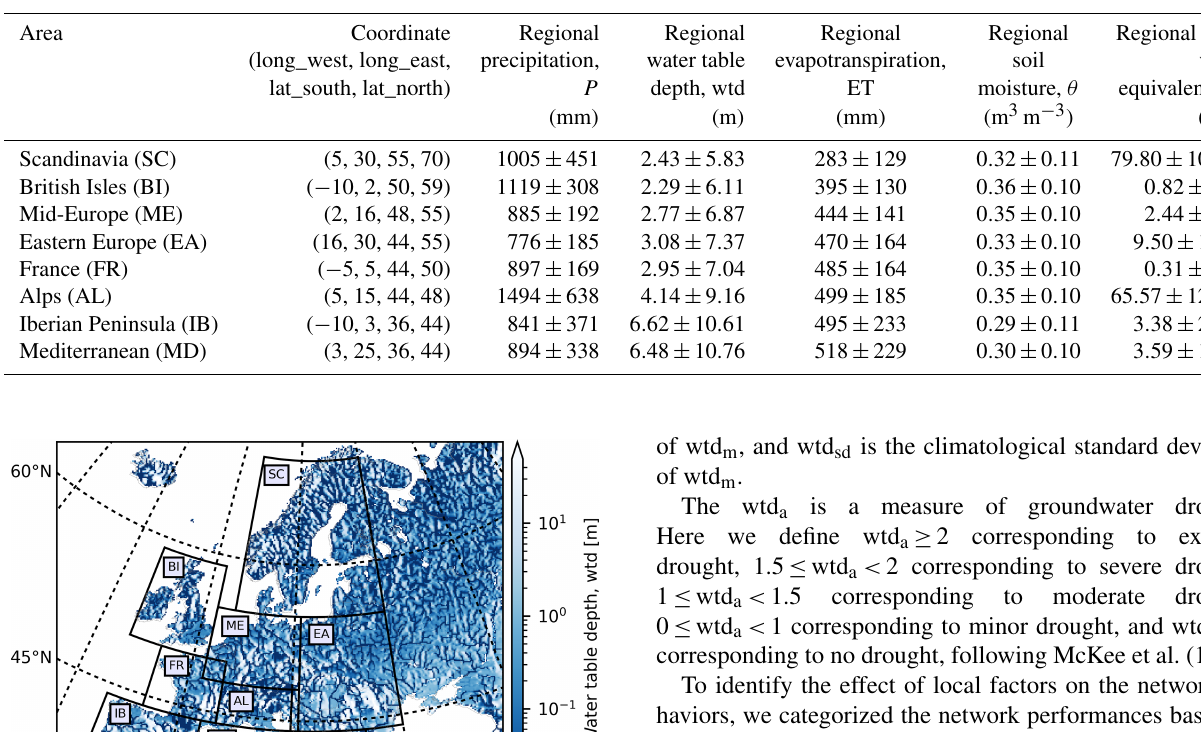
Table 1. Overview of the PRUDENCE regions, including region names and abbreviations, coordinates, and climatologic information ex- tracted from the TSMP-G2A data set (expressed as average ± standard deviation).